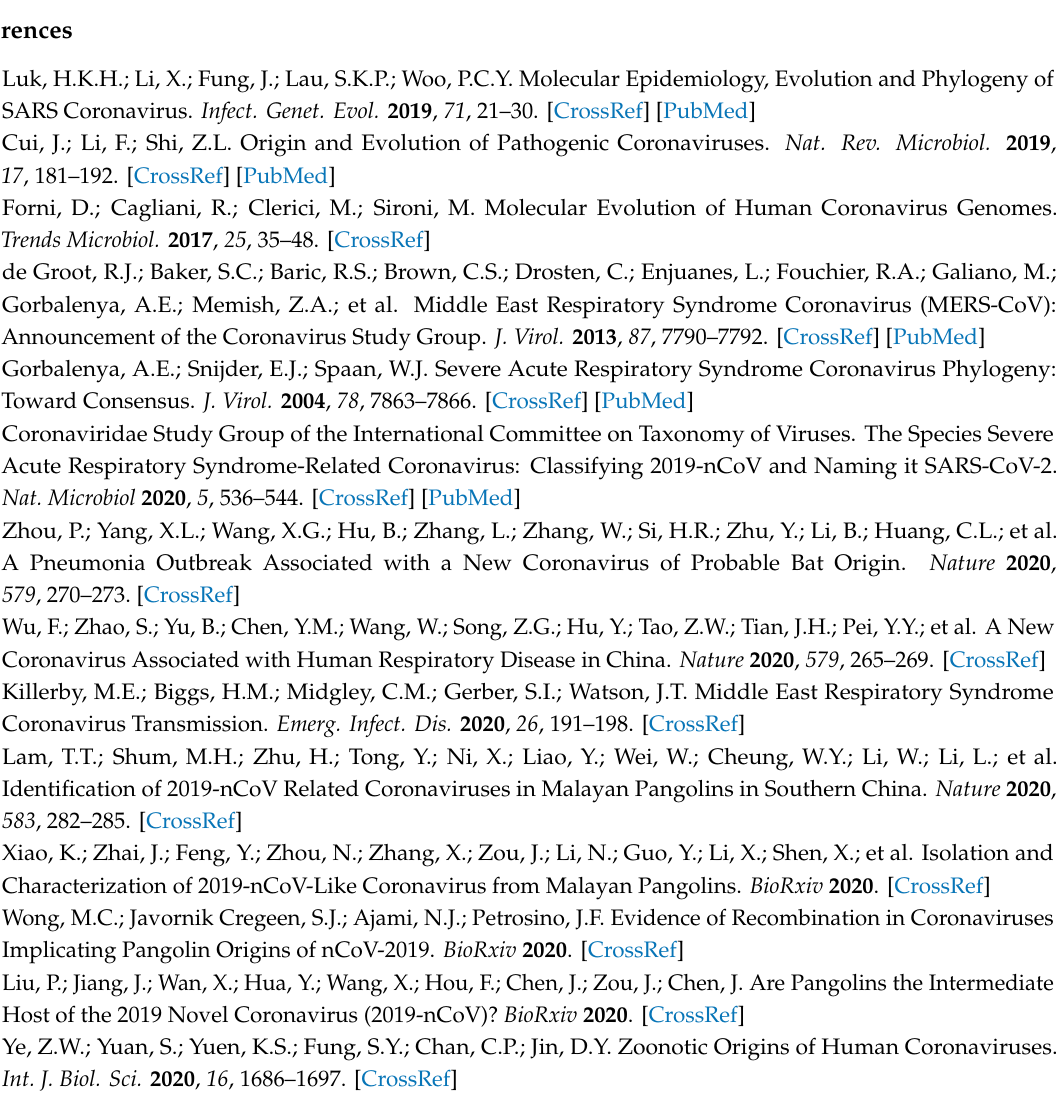
Table S1. List of viral strains analyzed in this study. Table S2. Analysis of episodic diversifying selection in merbecovirus ORFs. Table S3. Analysis of episodic diversifying selection in embecovirus ORFs. Figure S1. Episodic diversifying selection in sarbecoviruses. Figure S2. Episodic diversifying selection in merbecoviruses. Figure S3. Episodic diversifying selection in